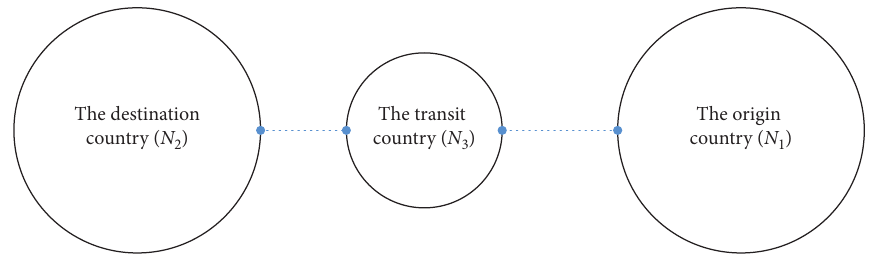
Figure 1: The tripartite main body in the construction of an international transport